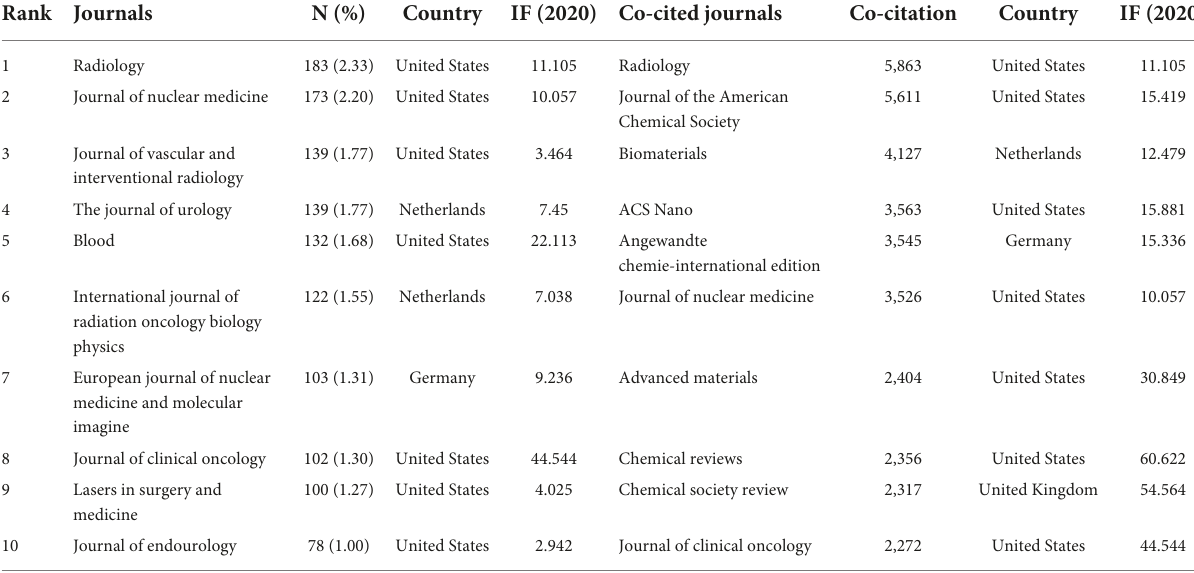
TABLE 3 The top 10 journals and co-cited journals in the research on the association of rare earth elements with cancer [n